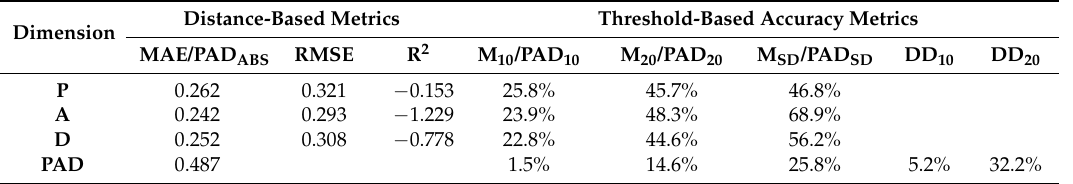
Table 6. Accuracy metrics for reference mapping matrix applied on the SYNE-ANEW dataset.